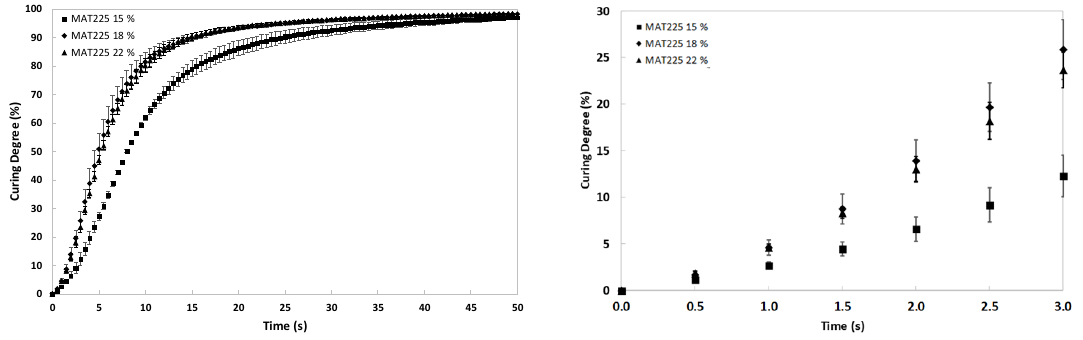
Figure 9. ( Left ) Curing degree of the MAT225 with a 15 ( ■ ), 18 ( ♦ ), and 22 wt.% ( ▲ ) fibre content. ( Right ) Magnification from 0 to 3 s time of curing.